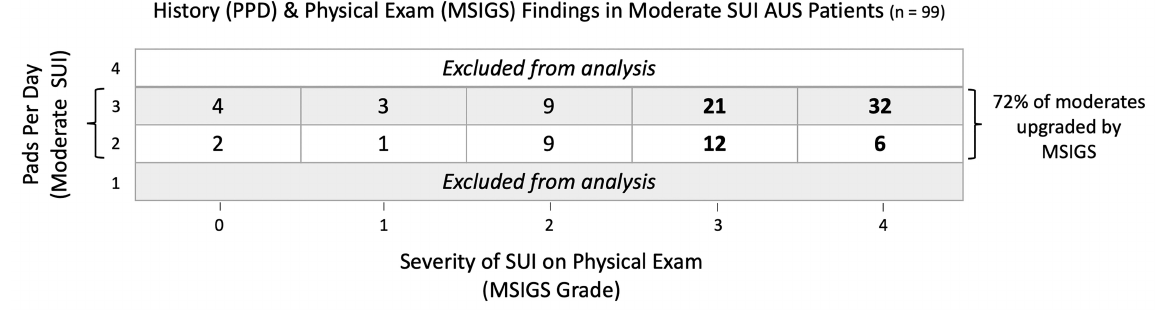
Figure 2 - Relationship between preoperative PPD usage and Male Stress Incontinence Grading System (MSIGS) grade among AUS patients with reported moderate